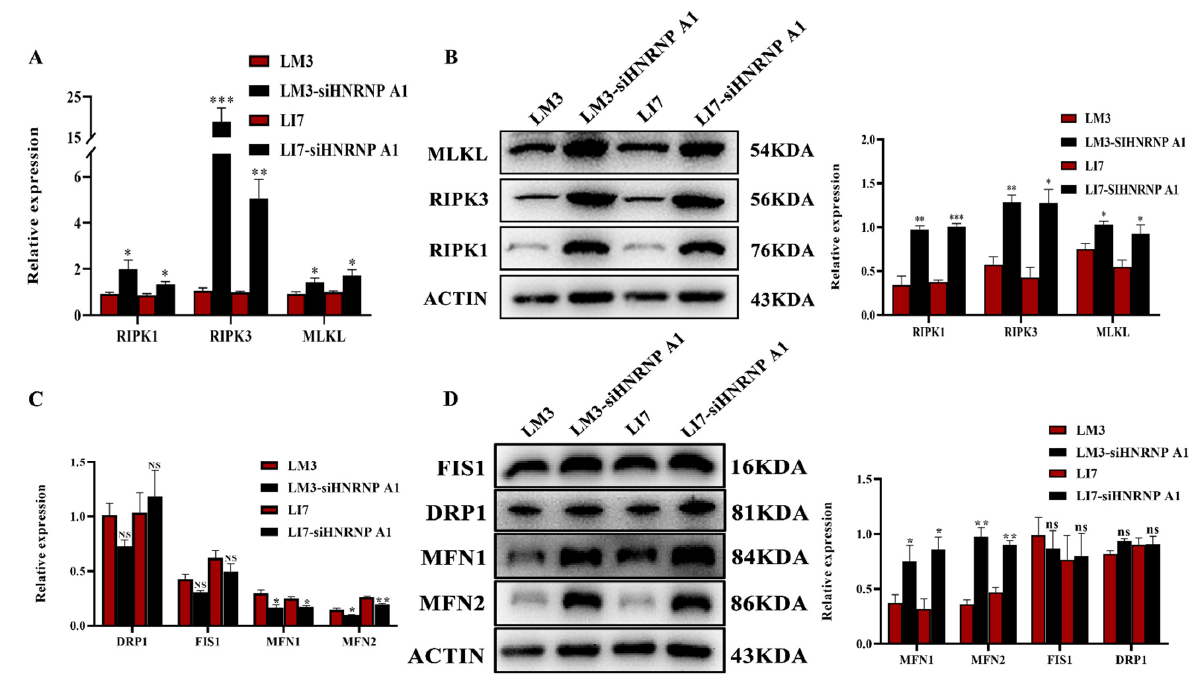
Figure 5. HNRNP A1 regulates necroptosis and mitochondrial dynamics. ( A , B ) The expression of RIPK1, RIPK3 and MLKL after knocking down of HNRNP A1 detected by qRT-PCR and WB. ( C , D ) The expression of DRP1, FIS1, MFN1 and MFN2 after knocking down of HNRNP A1 detected by qRT-PCR and WB. * p < 0.05; ** p < 0.01; *** p < 0.001; NS, not significant. The data expressed as the mean ± SD.